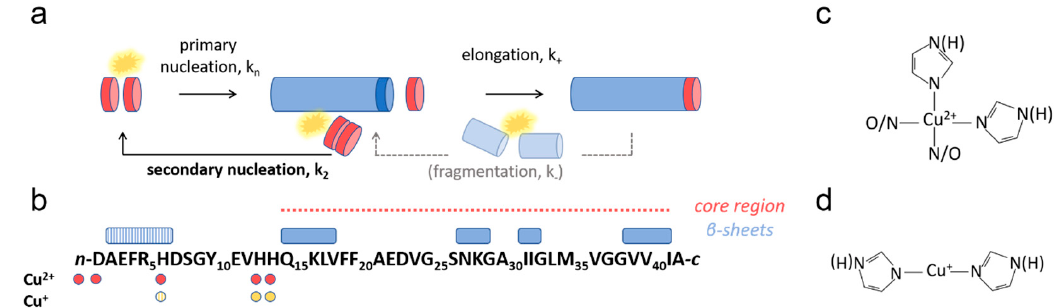
Figure 1. Amyloid formation and copper coordination by amyloid- β (A β )(1-42). ( a ) Schematic illustration of the reaction steps involved in nucleated amyloid fibril formation, including primary nucleation, elongation, secondary nucleation, and fragmentation. The kinetics of the aggregation of A β (1-42) alone is dominated by the generation of new aggregates through secondary nucleation (bold text), whereas fragmentation (shadowed) plays no significant role. ( b ) A β (1-42) primary structure with proposed amyloid fibril core β -sheets, according to recent high-resolution structural models indicated by blue boxes [73,74]. Note that one model reports β -sheet formation also at the N-terminus, albeit without participation in the formation of the core. Coordination sites for Cu 2 + and Cu + are indicated by red and yellow dots, respectively. ( c , d ) Consensus coordination mode of ( c ) Cu 2 + and ( d ) Cu + , with respective ligation partners [65] .